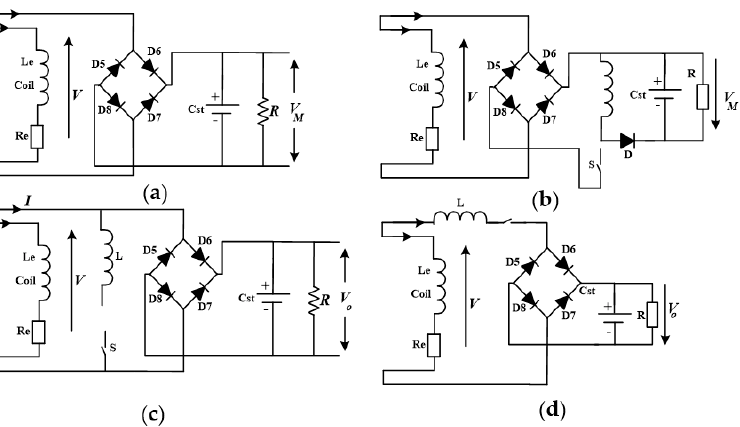
Figure 20. Conventional vibration-based energy harvesting circuit: ( a ) standard, ( b ) SECE, ( c ) parallel SSHI, and ( d ) series SSHI circuit [118]. Reprinted with permission from ref. [118]. Copyright 2015 Elsevier.